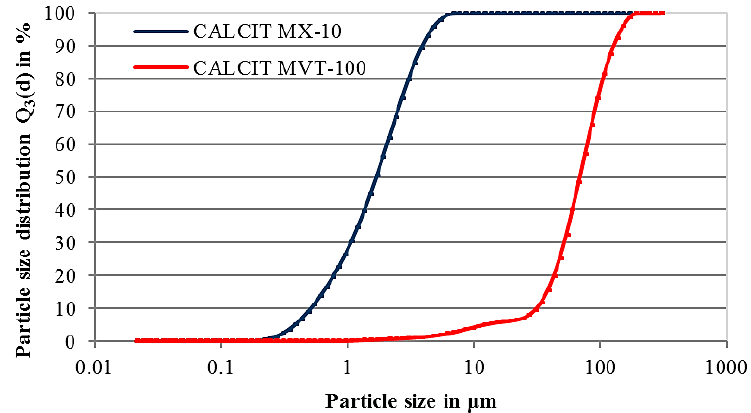
Figure 1. Cumulative size distribution functions of both used materials (laser Mastersizer 2000).